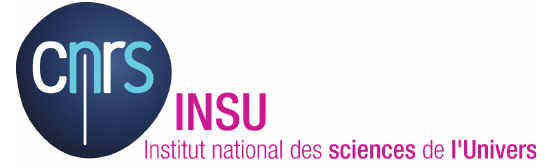
Figure 7 (lower panel) represents relative differences in % between these two set of tropospheric ozone partial columns for all the 33 hourly mean data of the comparison. Mean dif- ferences between these two partial columns were calculated using this